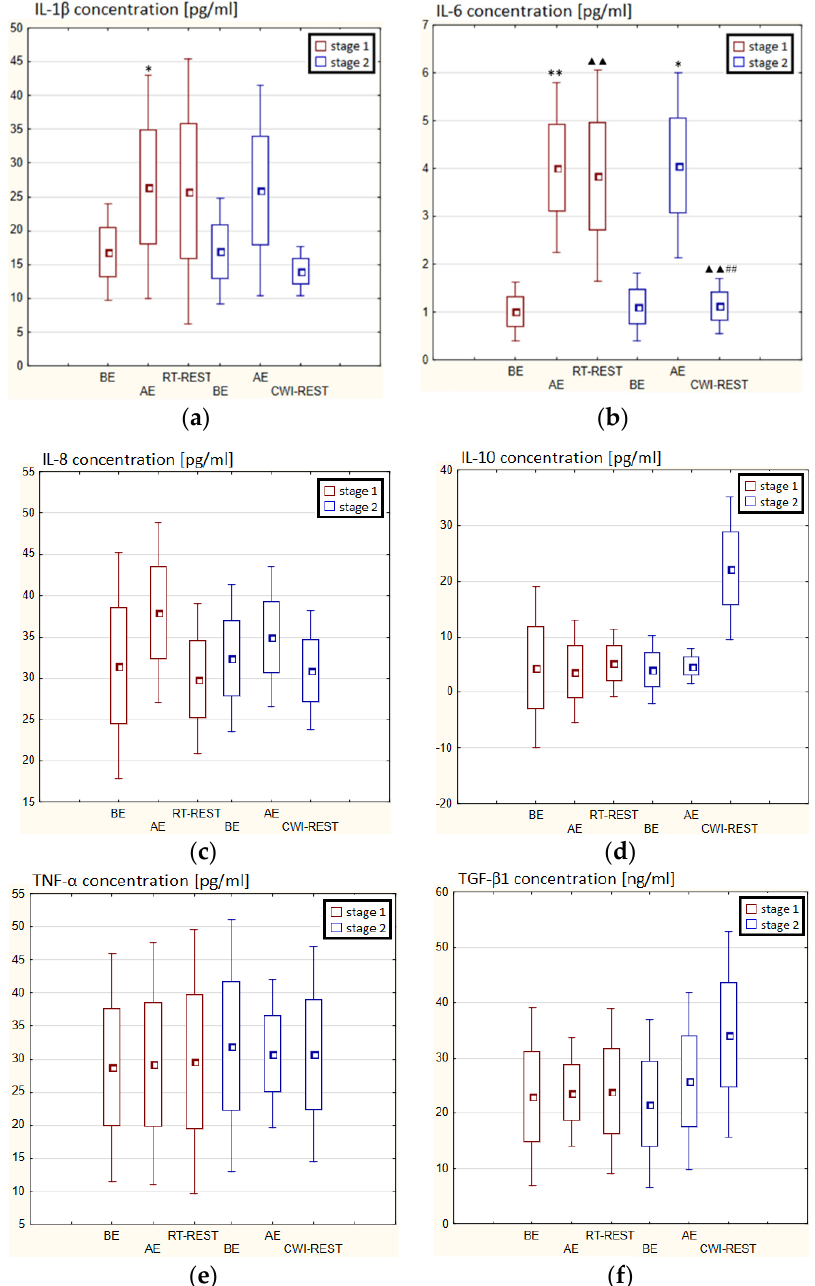
Figure 6. The concentration of selected cytokines in blood serum of winter swimmers ( n = 22) in Experiment I: ( a ) IL-1 β concentration; ( b ) IL-6 concentration; ( c ) IL-8 concentration; ( d ) IL-10 concentration; ( e ) TNF- α concentration; ( f ) TGF- β 1 concentration. Data are presented as the mean values ± SD. IL-1 β —interleukin 1 β , IL-6—interleukin 6, IL-8—interleukin 8, IL-10—interleukin 10, TNF- α —tumor necrosis factor α , TGF- β 1—transforming growth factor β 1, BE—before exercise, AF—after exercise, RT-REST—20-min recovery at room temperature, CWI-REST—20-min recovery at room temperature combined with 3-min cold water immersion, * p < 0.05 vs. BE, ** p < 0.001 vs. BE, ▲▲ p < 0.001 vs. AE, ## p < 0.001 vs. RT-REST.